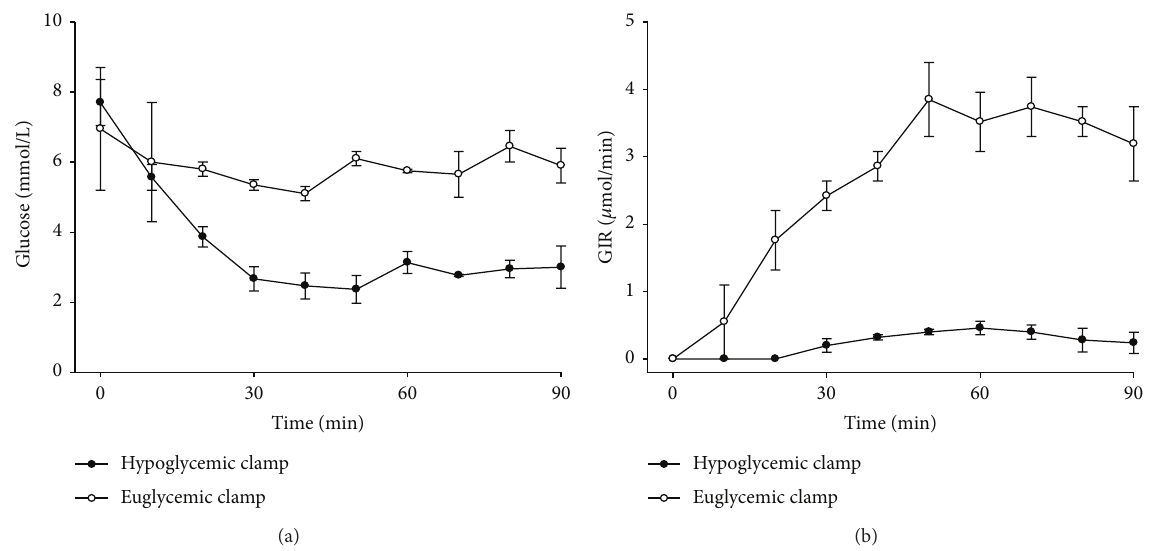
Figure 1: Example of glucose clamp experiments. Glucose levels and glucose infusion rates (mean ± SEM) during euglycemic clamp (aiming at the target level of 6mmol/L glucose, 𝑛 = 4 ) and hypoglycemic clamp (aiming at 2.5 mmol/L glucose, 𝑛 = 3 ) in C58BL/6J mice. GIR is glucose infusion rate in the two